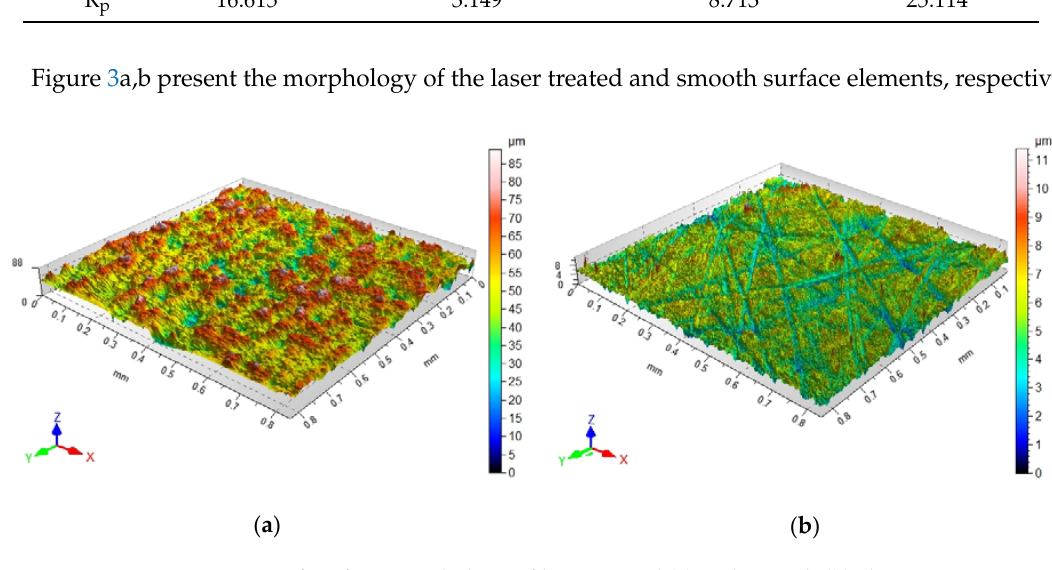
Figure 3. Images of surface morphology of laser treated ( a ) and smooth ( b ) elements.